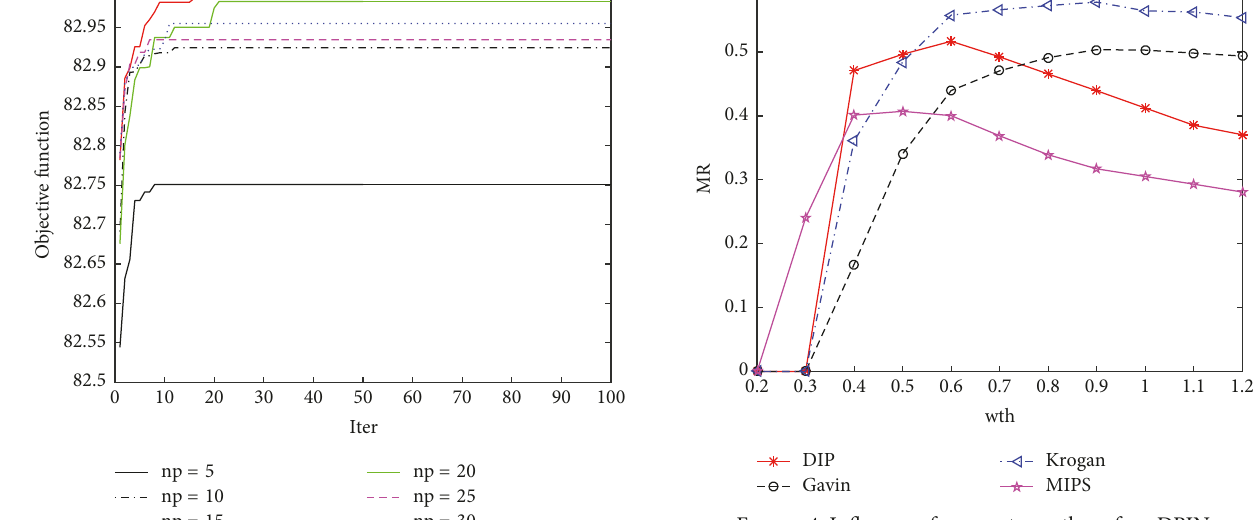
Figure 4: Influence of parameters wth on four